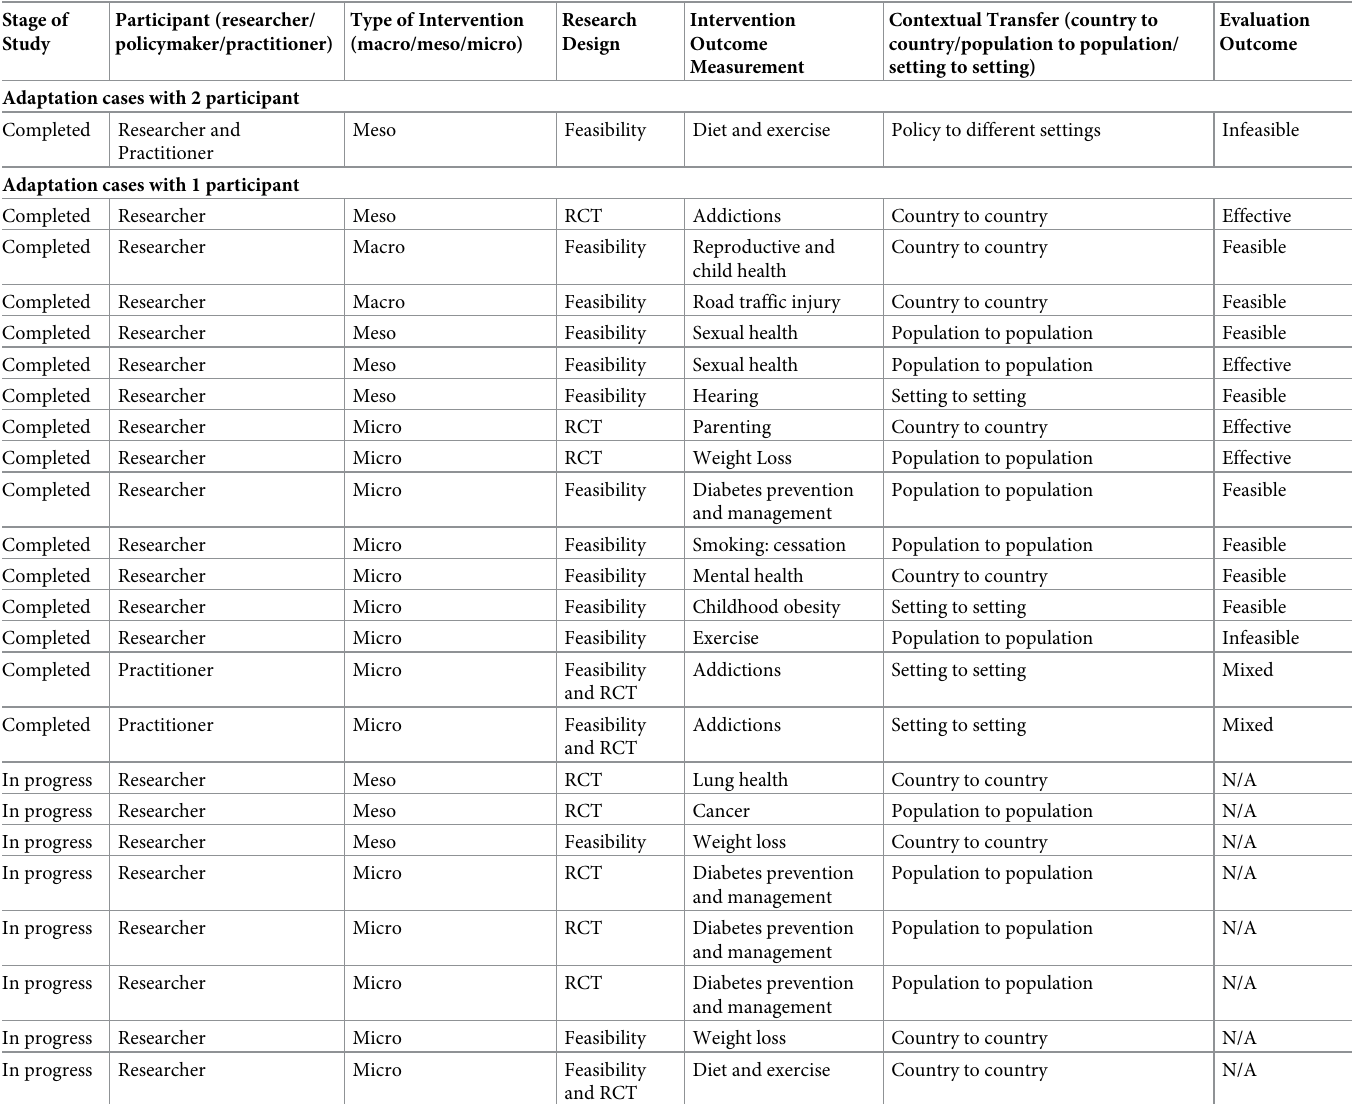
Table 1. Recruited sample